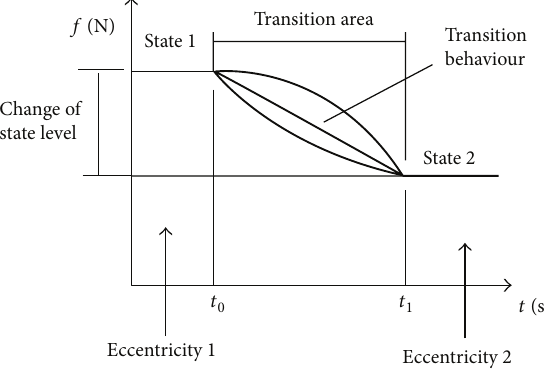
Figure 4: Schematic of transition between